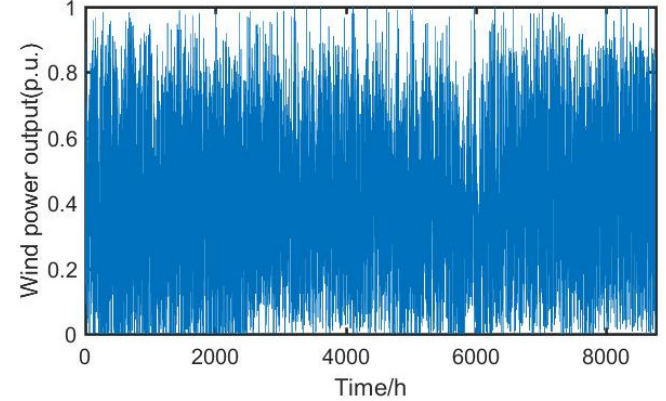
Figure 1. Annual fluctuation of wind power output.